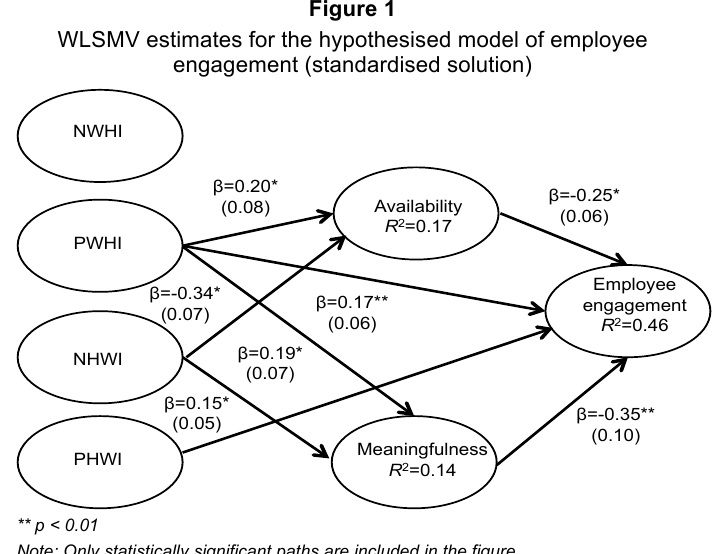
WLSMV estimates for the hypothesised model of employee engagement (standardised